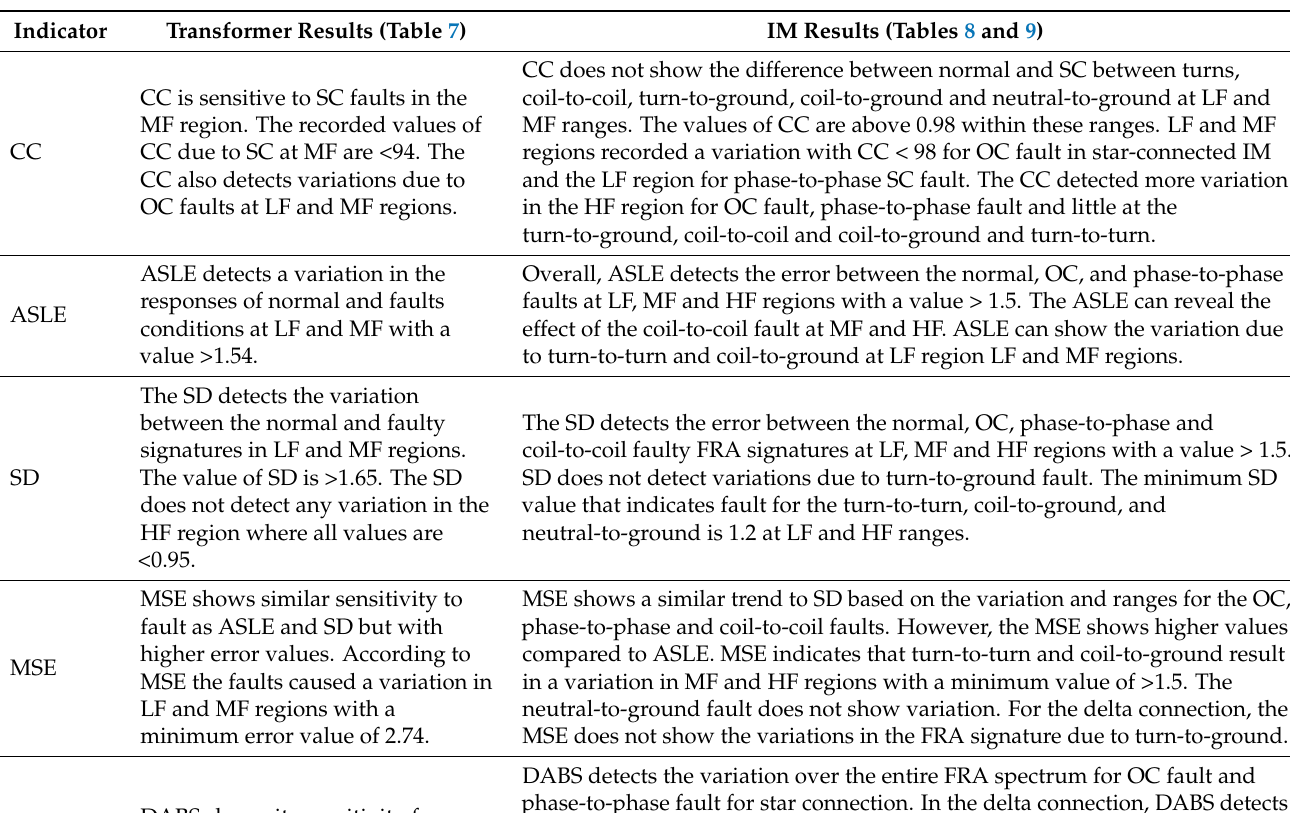
Table 10. Statistical indicators sensitivity analysis and comparison of the obtained results for the power transformer and